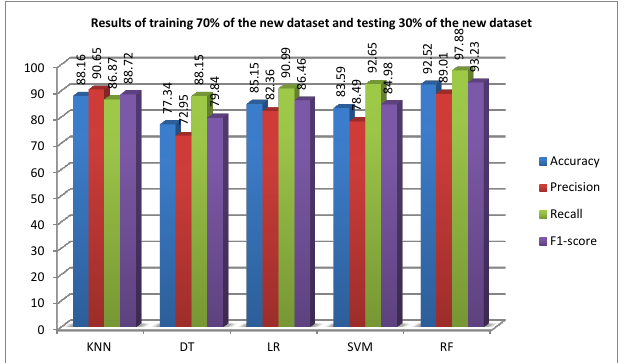
Figure 9. The performance of supervised machine learning algorithms trained on 70% of the new dataset and tested on 30% of the new